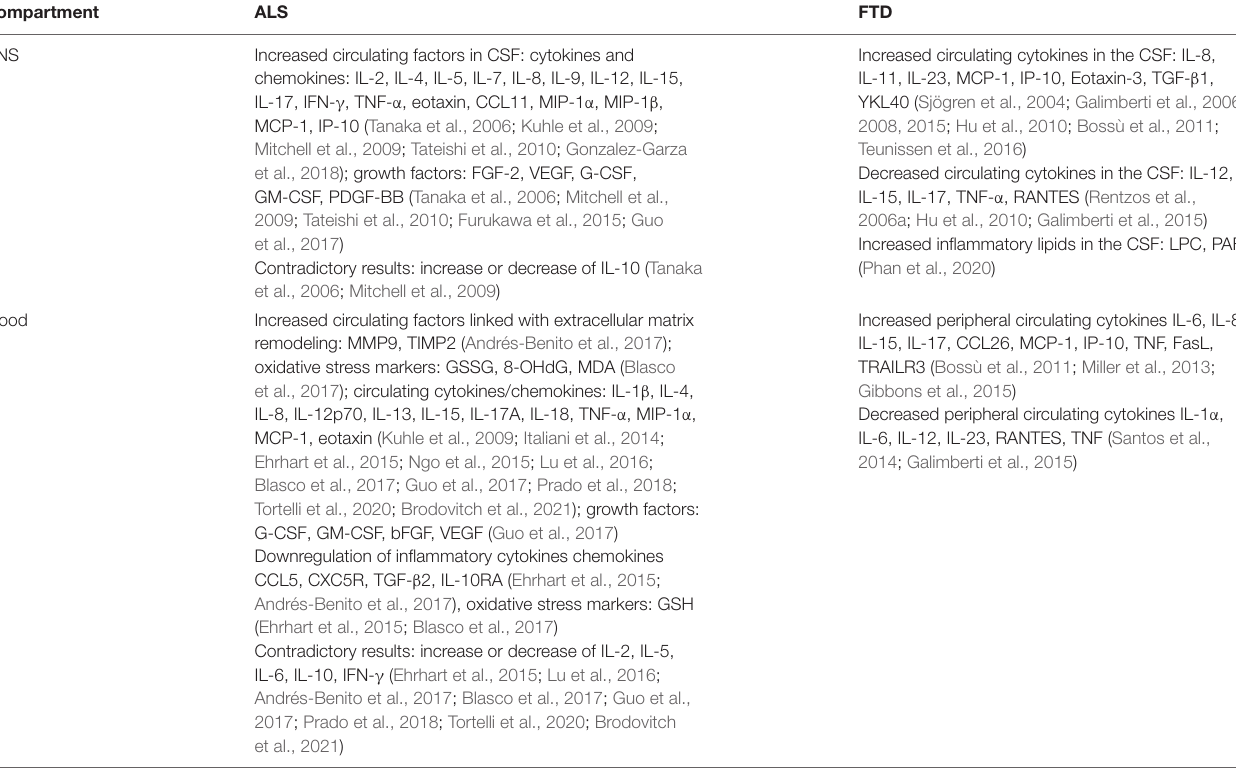
TABLE 1 | Publications reporting CSF and blood circulating inflammatory molecules in ALS and FTD patients.